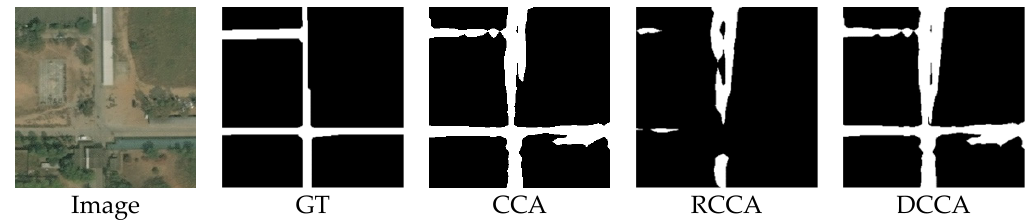
Figure 22. Image, ground truth and the output compilation.